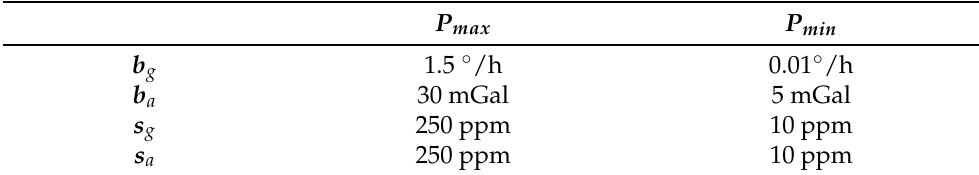
Table 2. The values of P max and P min used in the experiment.